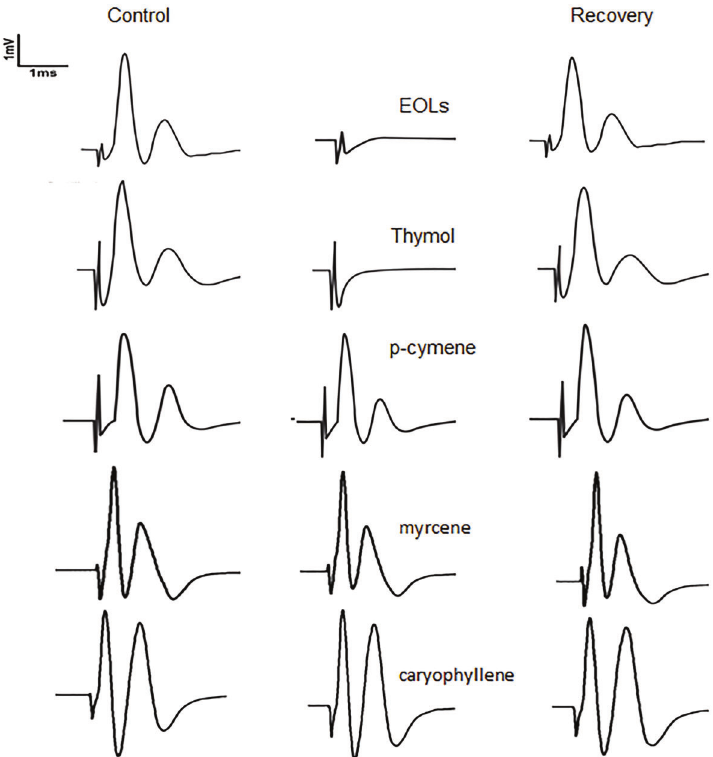
Figure 1. Compound action potential (CAP) inhi- bition of rat sciatic nerve promoted by essential oil of L. sidoides (EOLs), thymol and p-cymene. Illustrative CAP traces are shown in control, at the end of 180 min exposure to EOLs (200 m g/mL), thymol (100 m g/mL), p-cymene, caryophyllene and myrcene (10 mM) and after 180 min of washout